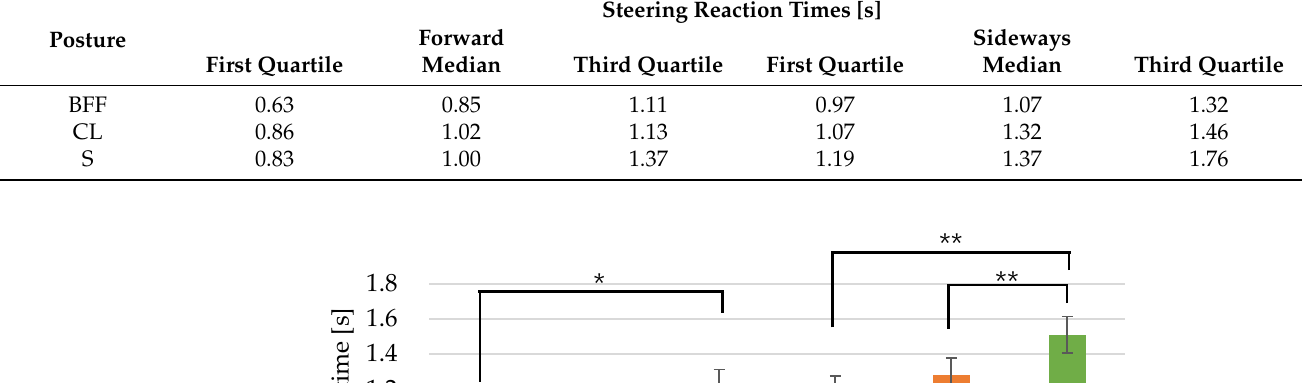
Table 5. Steering reaction times.